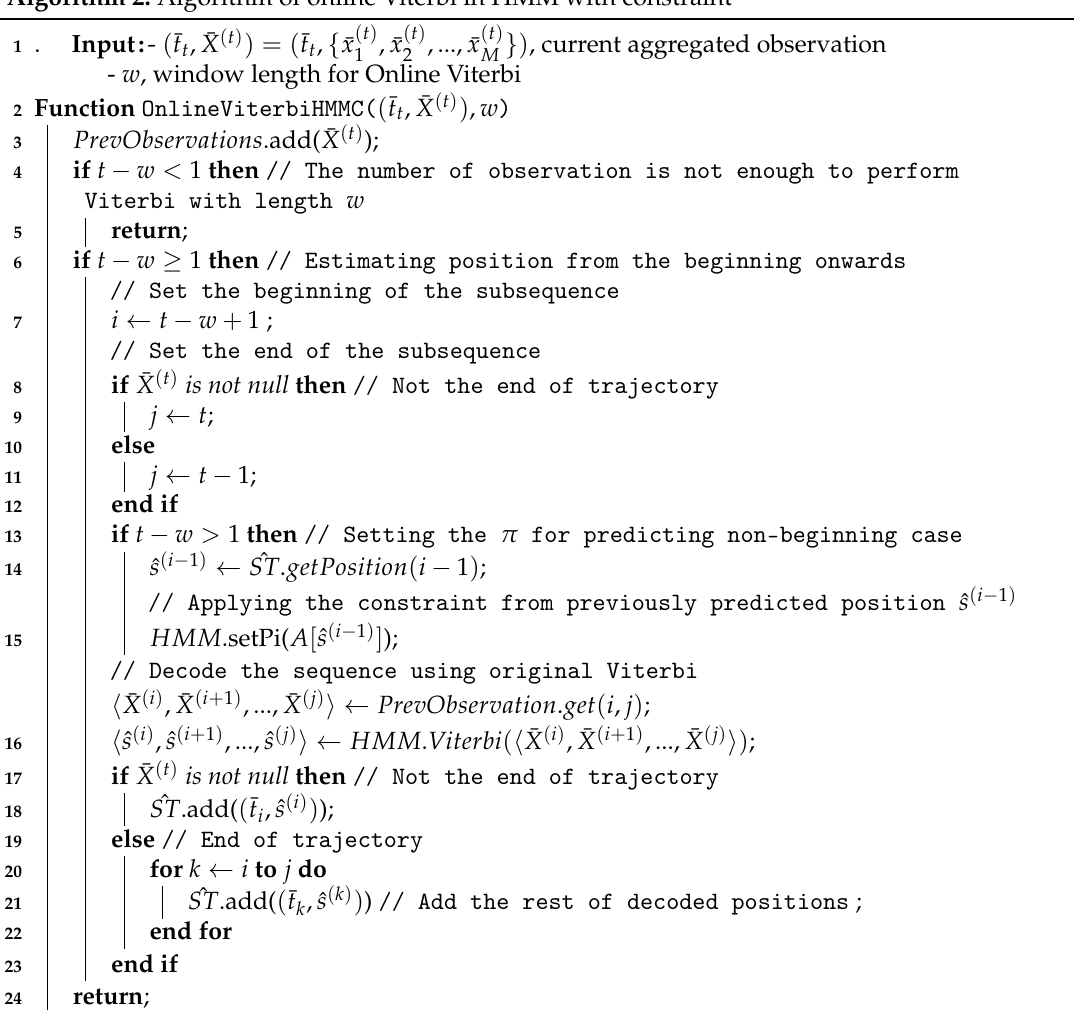
Algorithm 2: Algorithm of online Viterbi in HMM with